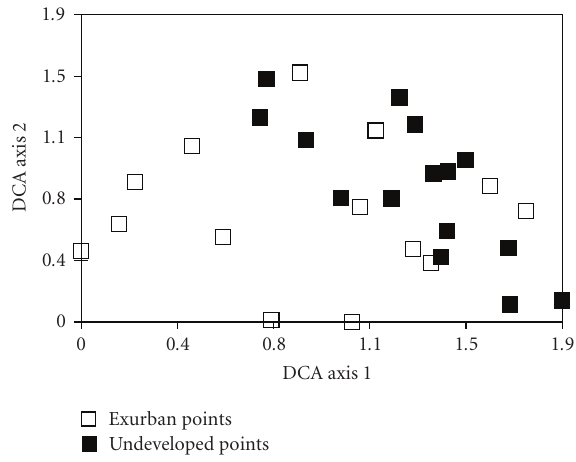
Figure 6: Detrended correspondence analysis of macroinverte- brates from soil core samples. Each point represents the position in ordination space of the macroinvertebrate community detected at one sampling point. The two axes show the relative position of each point in the multidimensional space defined by the macroinvertebrate orders found at each point. Thus, points with similar macroinvertebrate taxa cluster together on the graph. The first axis is the one along which most of the variation in the ordination space is arranged (eigenvalue = 0.30); the second axis is the second most important axis through the ordination space (eigenvalue =